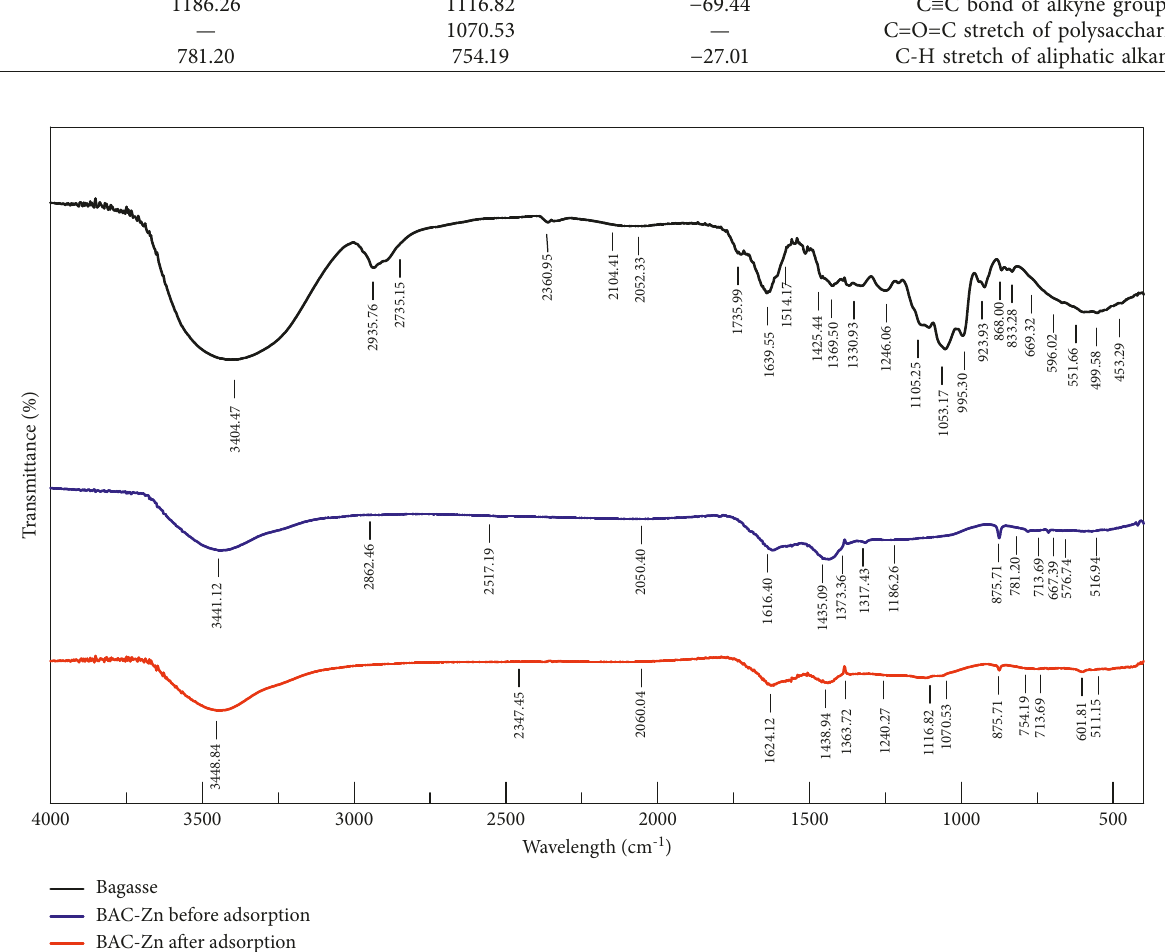
Figure 3: FTIR spectra of bagasse, BAC-Zn adsorbent before adsorption, and BAC-Zn adsorbent after